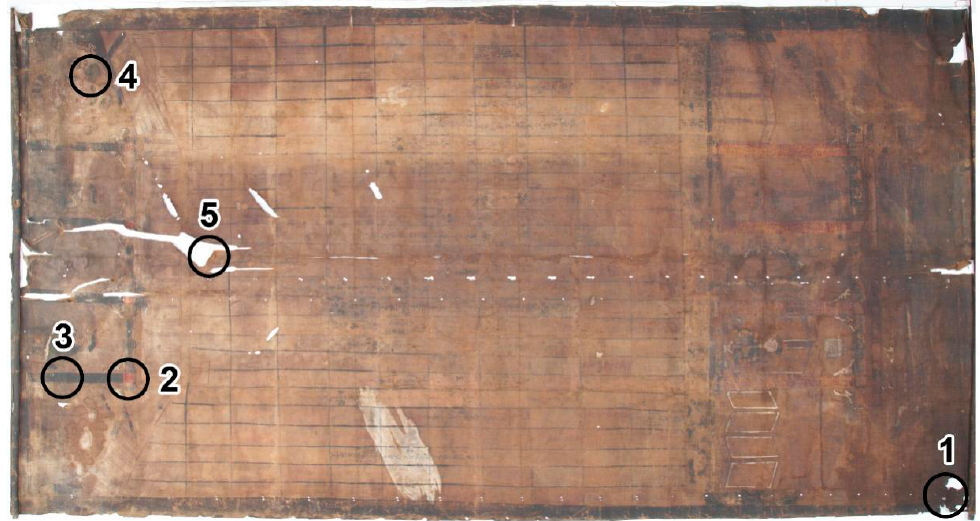
Figure 2. The sampling locations. Table 1. Analysis after sampling from the corresponding position of the painting. Sample No.